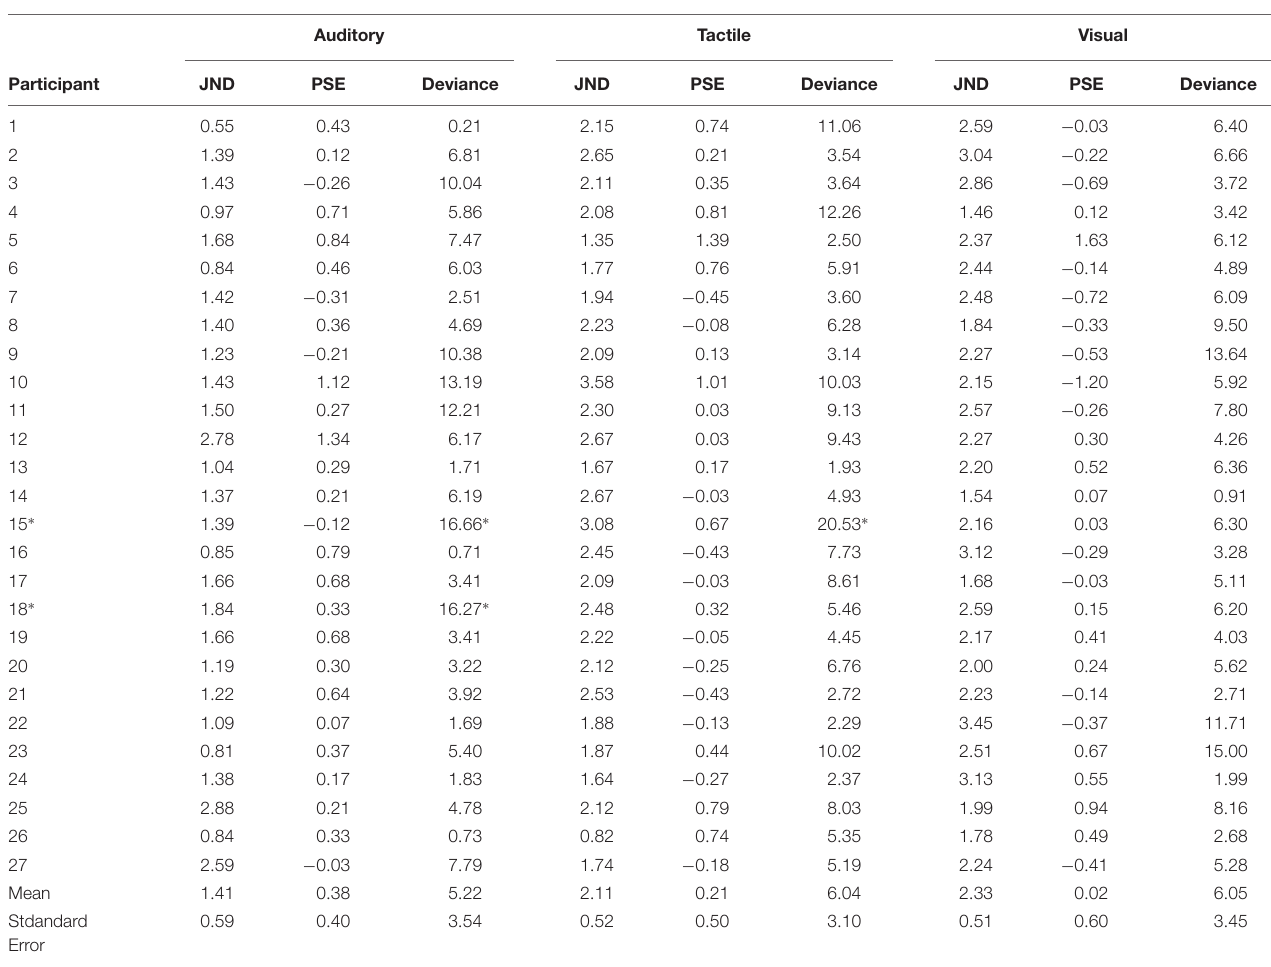
TABLE 1 | A summary of the behavioral responses (2-AFC